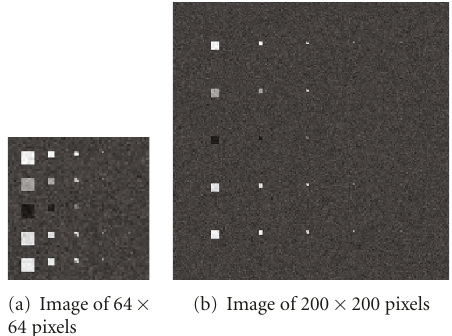
Figure 9: Target panels with four various sizes implanted in two uniform image BKGs with sizes of 64 × 64 pixel vectors and 200 × 200 pixel vectors.